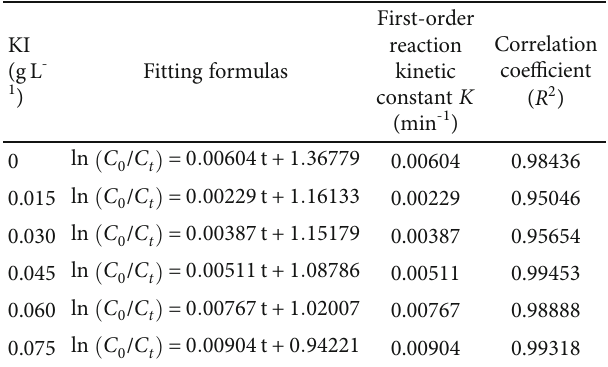
Figure 4: Adsorption models of W-7G in TiO solution and schematic diagram of the photocatalysis mechanism involving anion radicals: (a) 2 at acidic conditions (pH < pi); (b) at alkaline conditions (pH > pi); (c) radical reaction with dye molecules adsorbed on the surface; (d) radical reaction with halogen ions adsorbed on the surface. Table 3: Fitting results of fi rst-order reaction kinetics under acidic condition ( pH = 4 : 37 ).